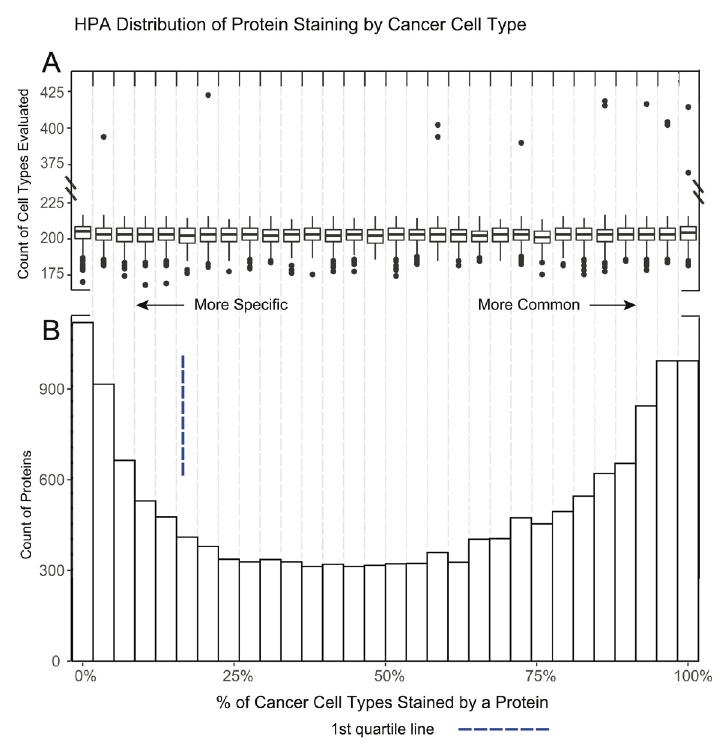
Figure 3. HPA distribution of protein staining by cancer cell type. A . A boxplot of the number of cell types evaluated per protein in each of the 30 histogram bins. The overall median of cancer cell types is 203 with the 1 st and 3 rd quartile of 199 and 207 respectively. A number of outliers with ~2x more cell types evaluated are noted. Besides frequently tested cancers, the distribution reveals proteins are evenly scored across cancers, regardless of how frequently they are tested. B . A histogram demonstrating the percent of positive staining cancer cells per protein. This distribution is different from normal tissue as some cancer samples of the same cancer type can positively stain for a protein while other samples will not. Similar to normal tissue there seems to be an increase of proteins in the extreme ends of the specificity distribution.